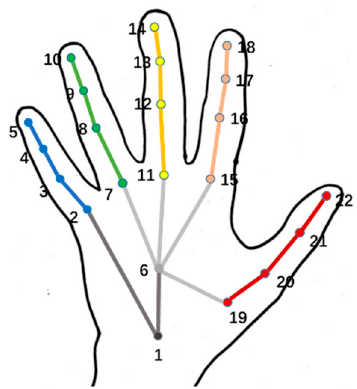
Figure 2. Twenty-two joints of a right-hand skeleton.